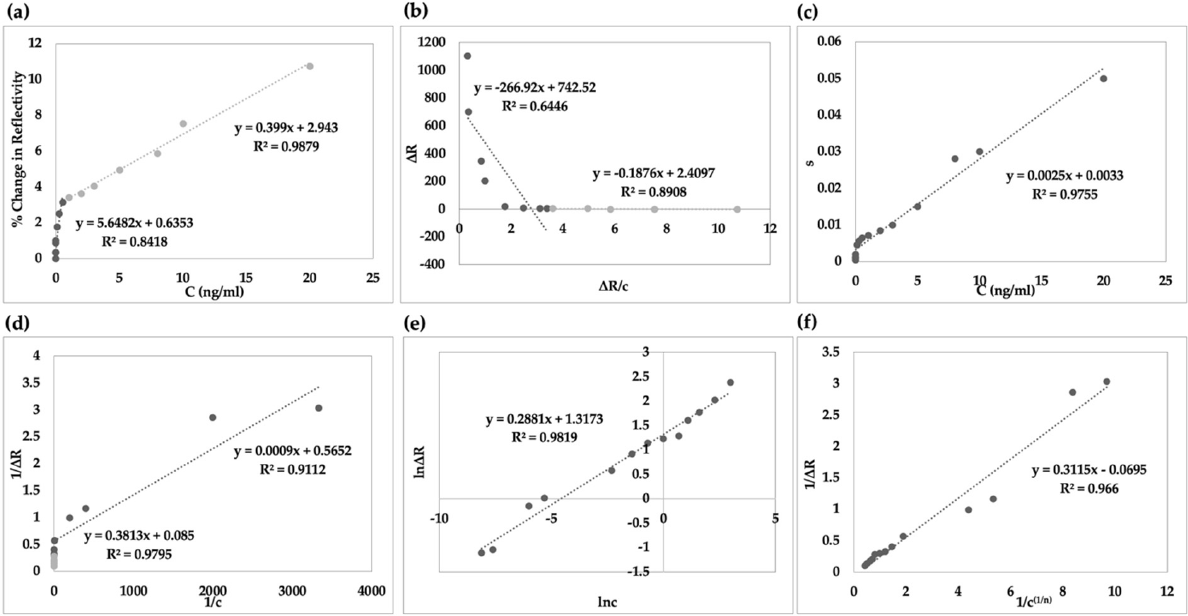
Figure 5. ( a ) Calibration curve; ( b ) association binding kinetic; ( c ) Scatchard equation; ( d ) Langmuir model; ( e ) Freundlich model; and ( f ) Langmuir–Freundlich model of AFM1 − imprinted plasmonic sensor. The AFM1 − MIP SPR sensor displayed a wide linear range of concentrations from 0.0003 ng/mL to 20 ng/mL. Table 1 shows the comparison of the different sensor systems, with their published and obtained limit-of-detection values. The designed plasmonic sensor had a good linear range and a low limit-of-detection value, as reported by the sensors; this showed that the novel molecularly-imprinted-nanofilm-coated enhanced plasmonic sensor was a suitable sensing